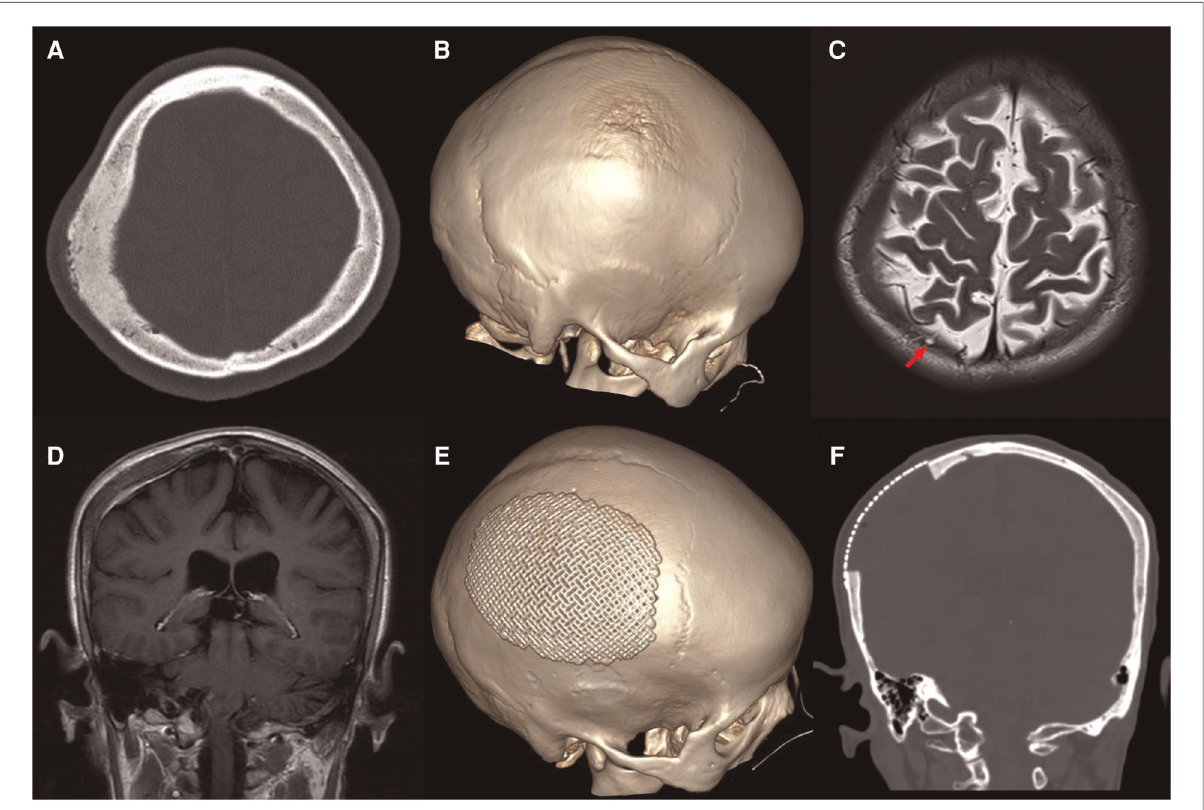
FIGURE 1 Preoperative images: ( A ) axial thin-cut skull CT shows an osteogenic lesion in the right parietal bone. ( B ) 3D-CT shows crater-like changes in the outer layer of the skull. Axial T2 imaging revealed a hypointense intraosseous lesion and arachnoid granules protruding into the diseased bone [( C ), red arrow]. ( D ) Coronal gadolinium-enhanced MR imaging exhibits mild to moderate homogeneous enhancement with an intense dural reaction. Postoperative CT shows total resection of the tumorized calvaria lesion with good coverage by a titanium mesh ( E,F